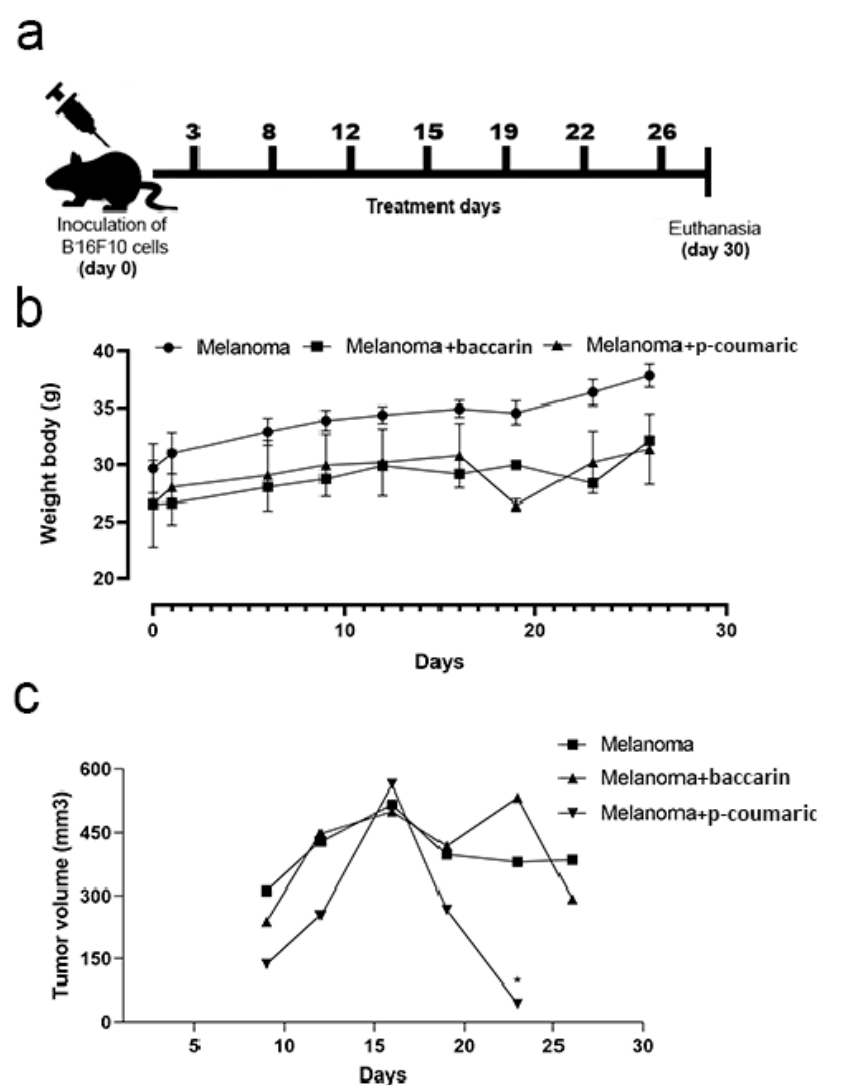
Figure 1. ( a ) Illustration of animal treatment days. ( b ) Representative graphic of body weight (g) during the experiment. ( c ) Representative graphic of the tumor volume (mm 3 ) analysis. Comparison between the experiments with baccharin and p-coumaric acid: Melanoma group (B16F10 concen- tration of 10 6 cell/mL and ingested PBS) and Melanoma + baccharin group that received treatment with baccharin compound (500 µ g/kg). Melanoma group (B16F10 concentration of 10 6 cell/mL and ingested PBS) and Melanoma + p-coumaric acid group that received treatment with p-coumaric compound, both for 26 days. * Data represents mean ±